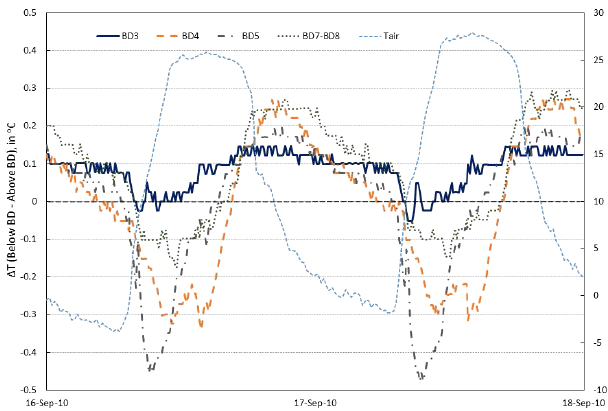
Figure 9. Spatial variability in stream temperature throughout indi- vidual beaver dams (BD). Temperature differences ( (cid:49)T ) were cal- culated based on 10min temperature records from locations down- stream and upstream of the beaver dam and pond. These data il- lustrate that there is a time lag between air temperature and stream temperature and that there can be measurable differences in temper- atures at the beaver dam spatial scale that vary diurnally. It further shows the variability in temperature differences between the